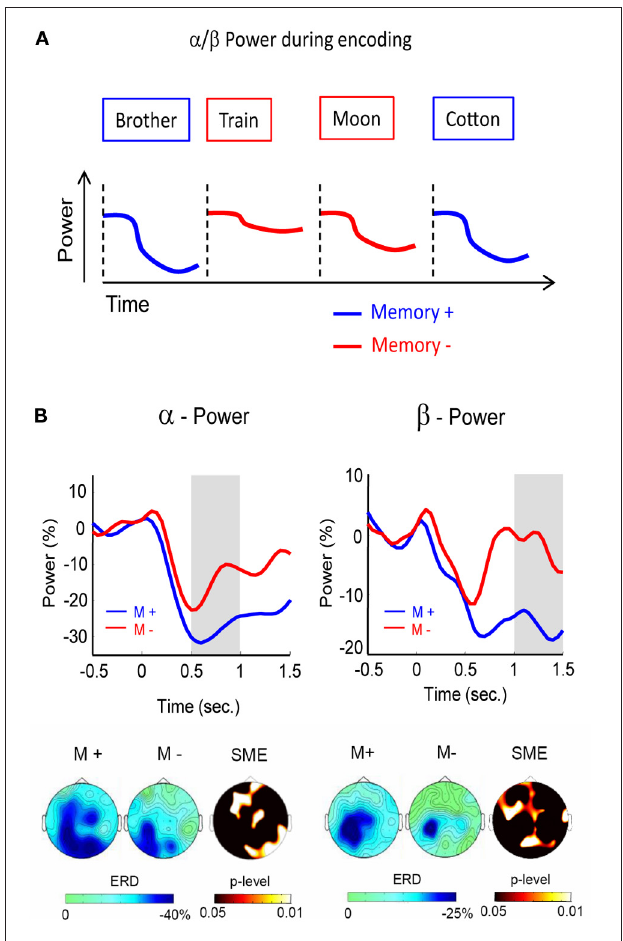
FIGURE 1 | The different frequency bands and their relation to memory. (A) A time-frequency power spectrum of a parietal electrode (Pz) is shown during a memory task. Time 0 indicates stimulus presentation. Power increases relative to baseline (red) can be seen in the theta and gamma frequency range, whereas relative power decreases (blue) emerge in the alpha and beta frequency range. (B) A schematic depiction of the power in the different frequency bands is shown and how they typically relate to memory. Blue refers to items for which memory succeeds (Memory + ), red refers to items for which memory fails (Memory − ).